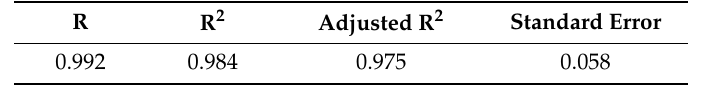
Table 5. Coe ffi cients for evaluating the goodness of fit of the regression model of